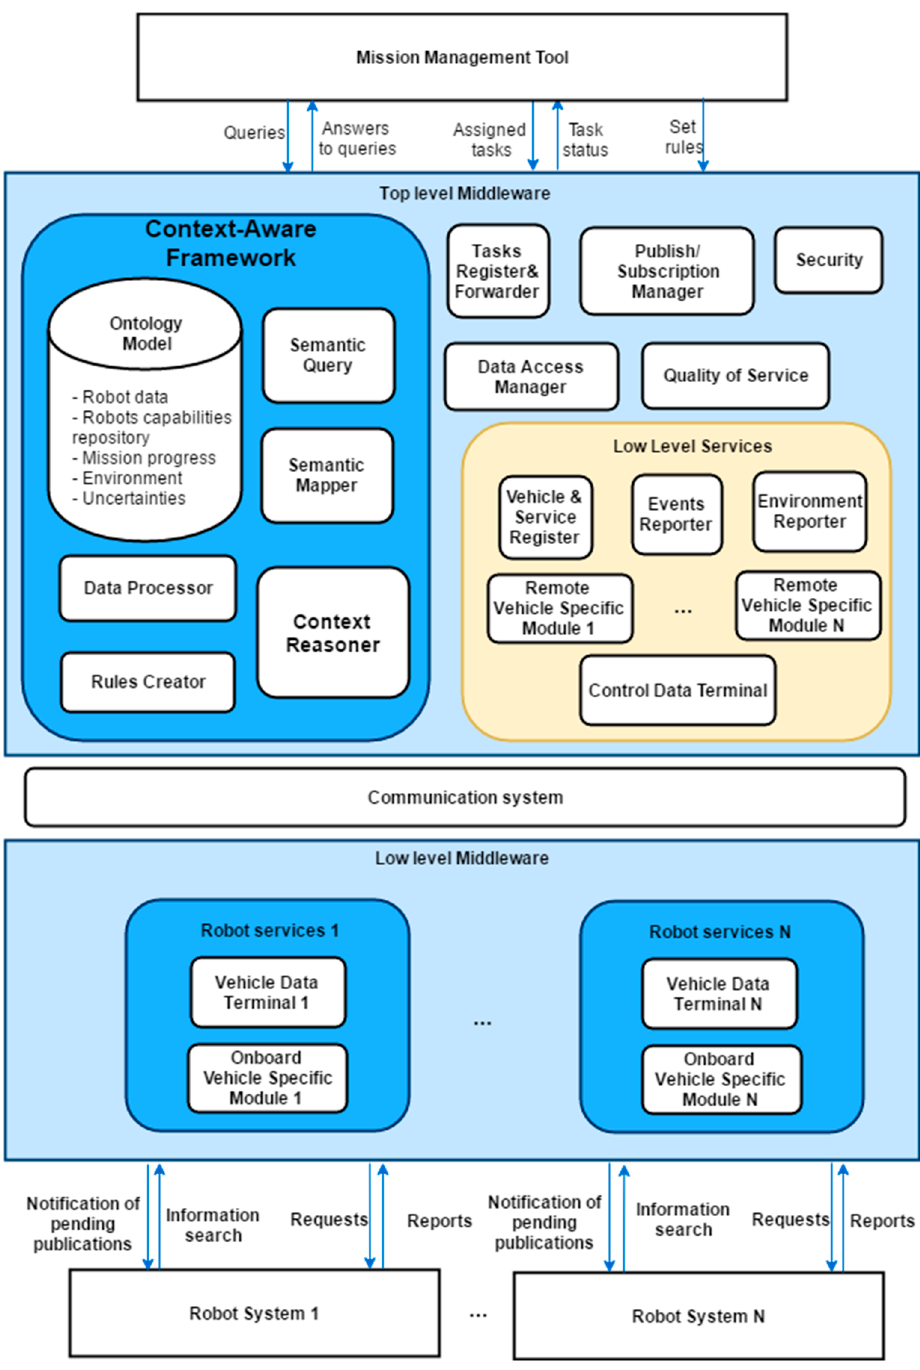
Figure 2. Overview of the proposed context-aware framework.